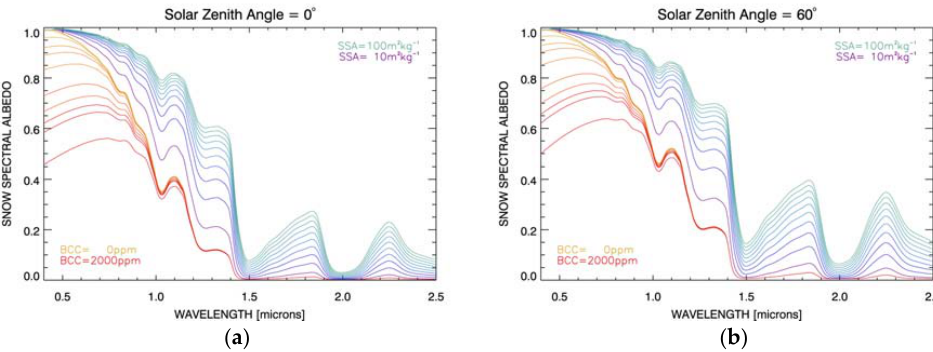
Figure 5. Snow spectral albedo versus wavelength simulated for different values of the snow Specific Surface Area (SSA) (green to purple lines) and for different black carbon content (orange to red lines) for SZA = 0° ( a ) and for SZA = 60° ( b ).